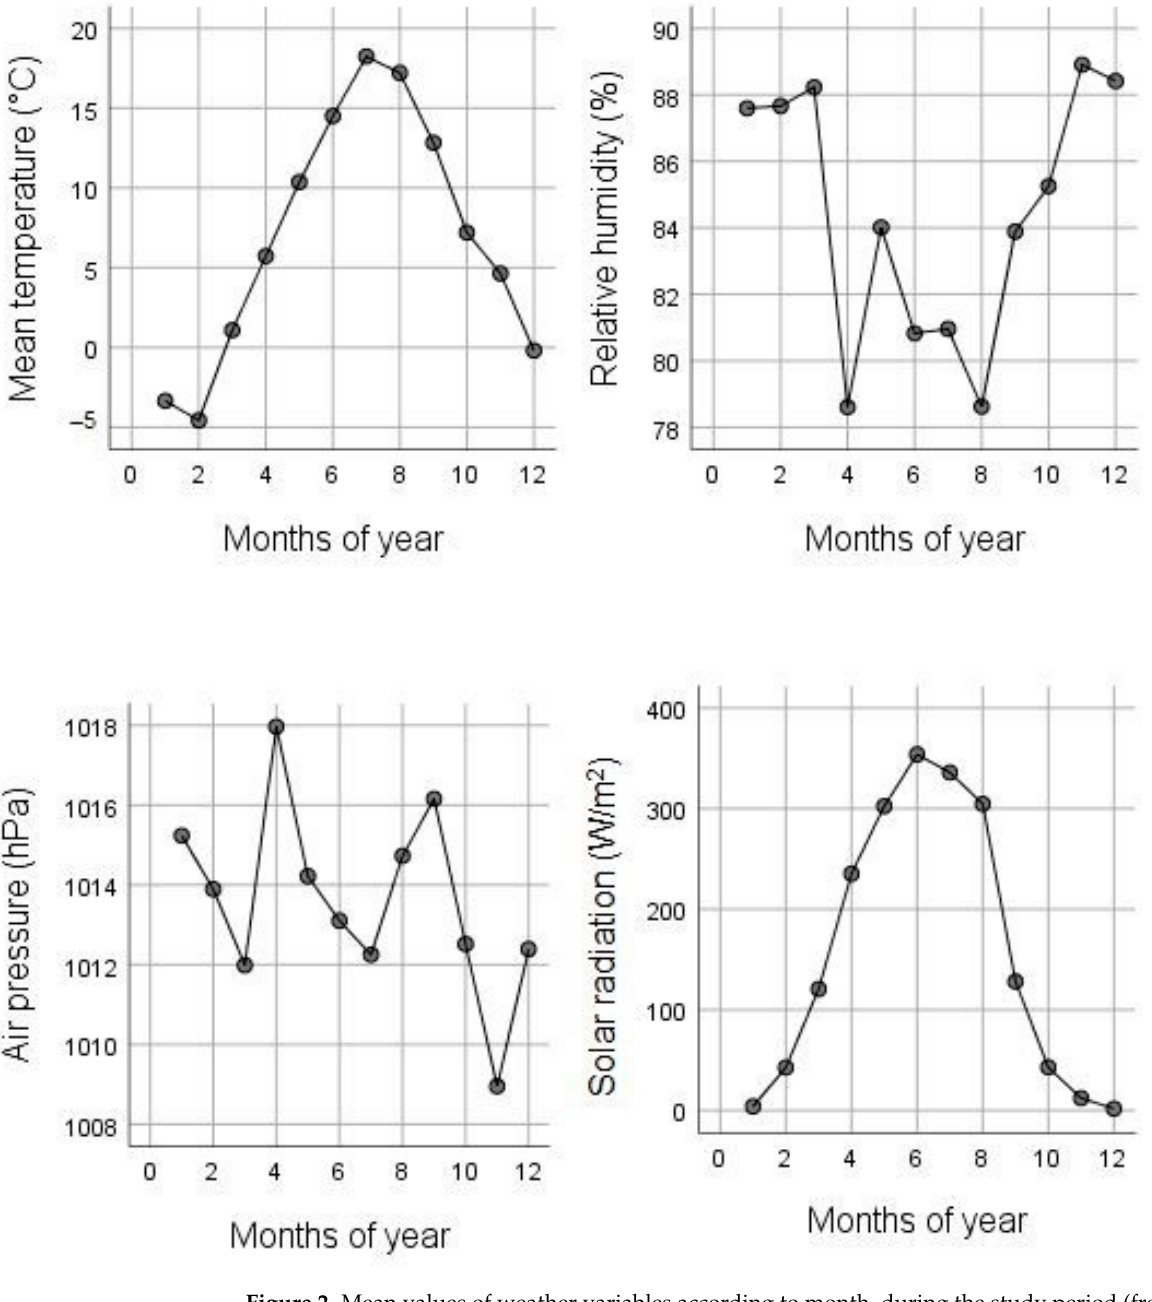
Figure 2. Mean values of weather variables according to month, during the study period (from June 2008 to October 2012). Error bars denote a 95% interval.